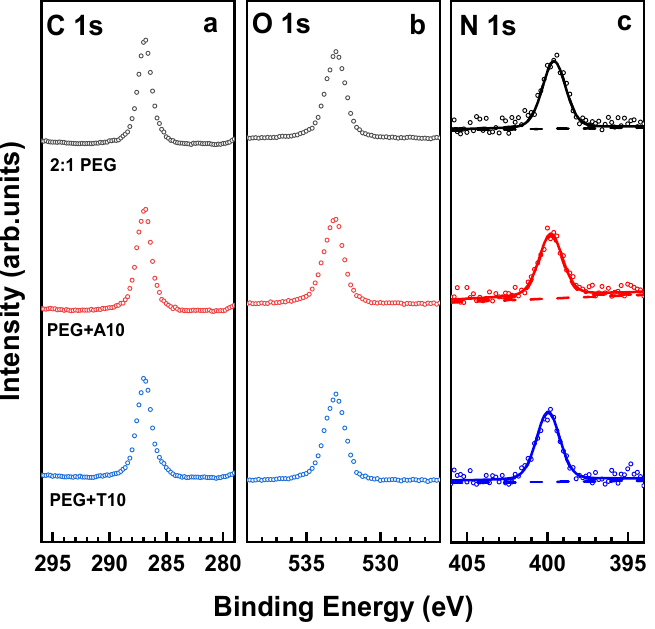
Figure 3. C 1s (a), O 1s (b) and N 1s (c) XP spectra of the 2:1 PEG films before (top curves) and after their incubation into the A10 and T10 solutions. The N 1s spectra are tentatively fitted by a single peak (solid lines) and a background (dashed lines).